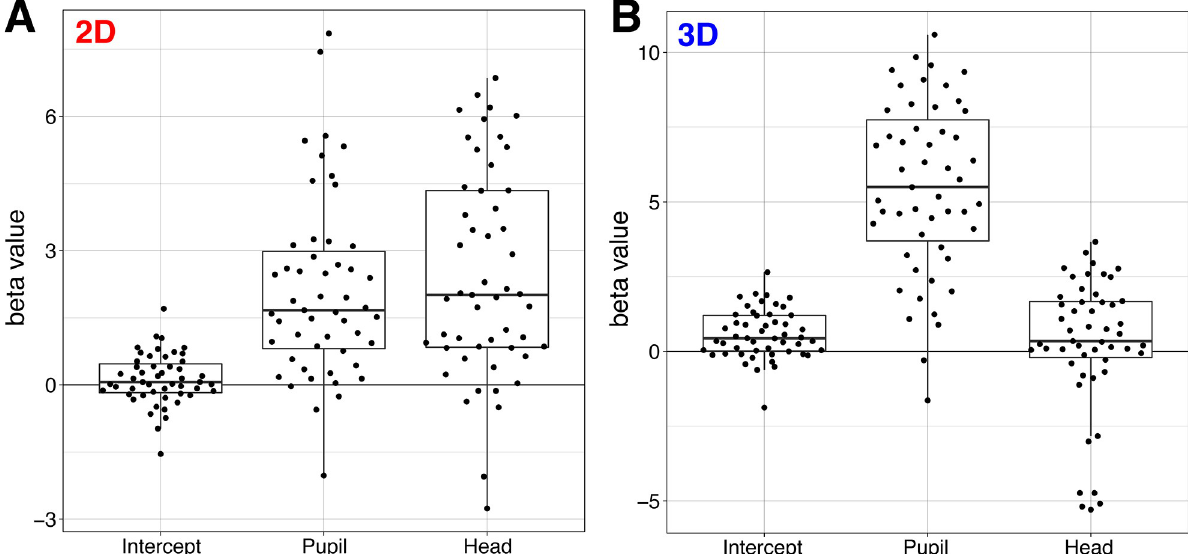
Fig 5. Boxplots of the estimated parameters. A) Estimates from the 2D condition indicate very strong and consistent effects of pupil shifts and head rotations, but not intercept. B) Estimates from the 3D condition indicate very strong and consistent effects of pupil direction, but not head direction, and a small positive effect of